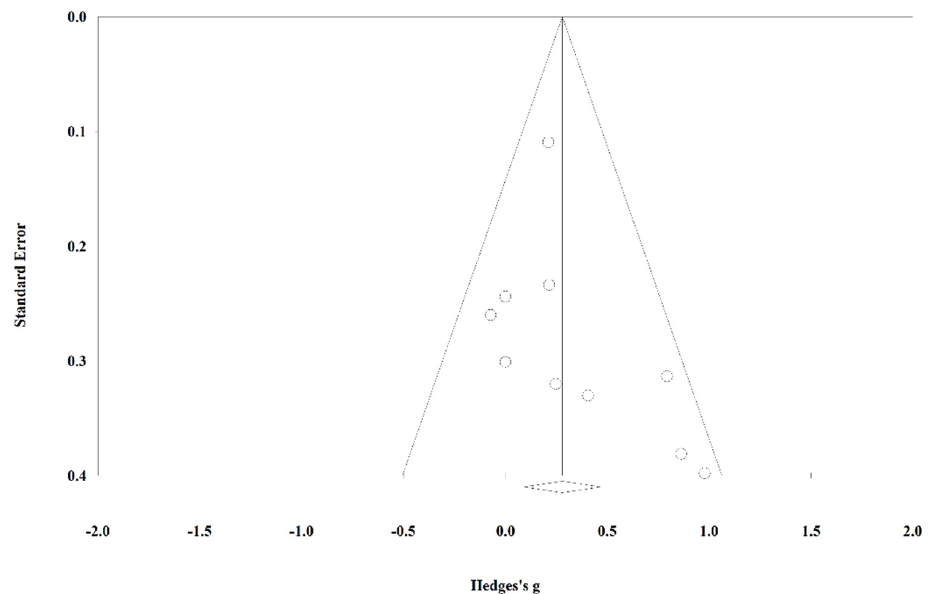
Figure 4. Funnel plot of effect sizes of sprint performance studies comparing external focus and internal focus.